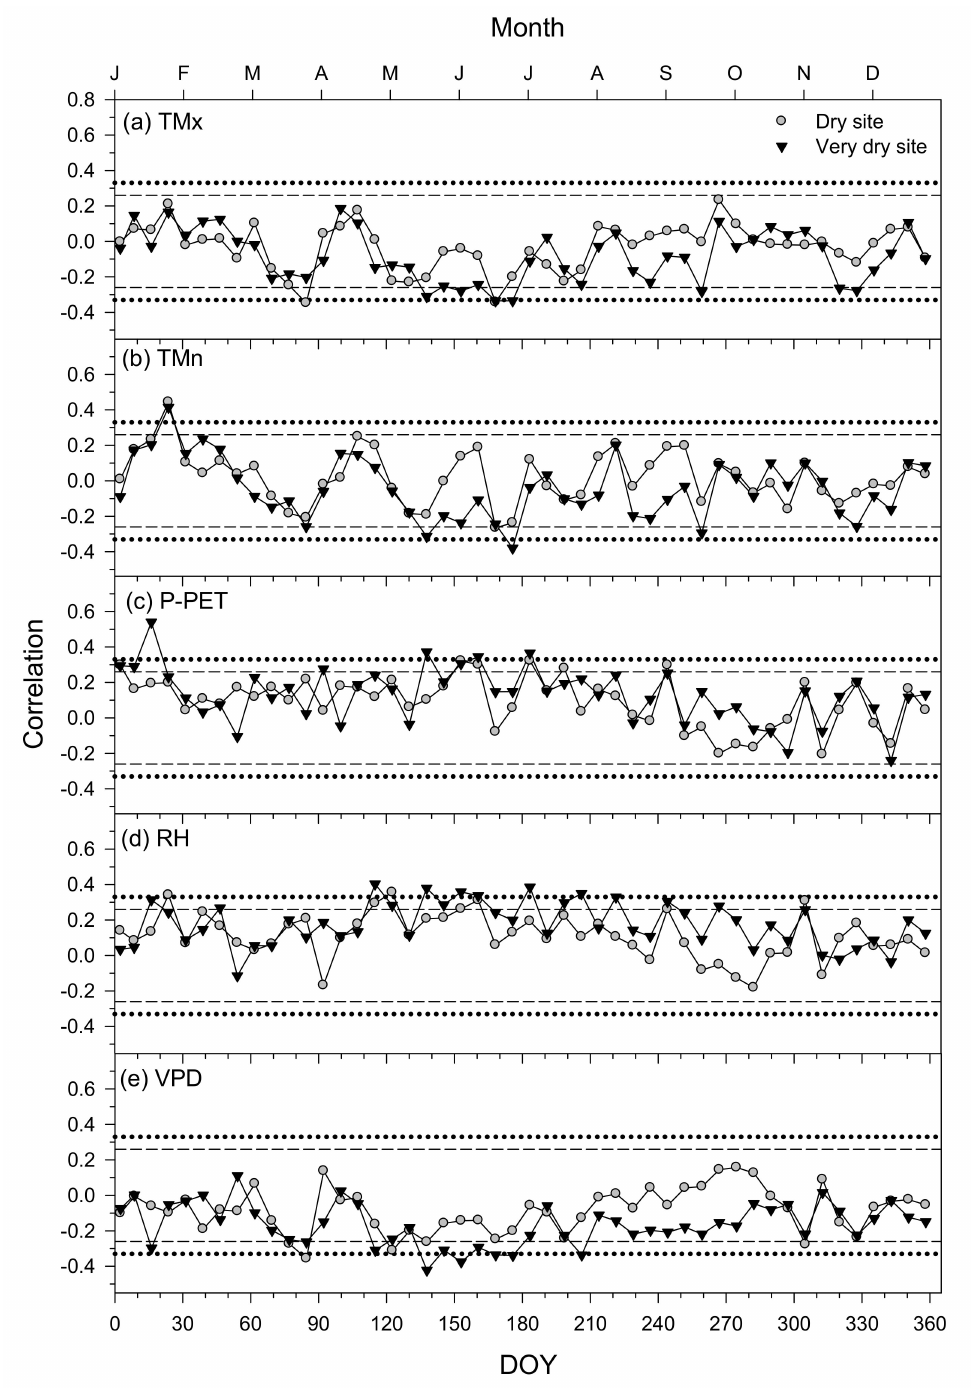
Figure 8. The climate–growth relationships of Pinus halepensis were assessed at a weekly resolution at the dry and very dry sites. The analyzed climate variables were ( a ) TMx, ( b ), TMn, ( c ), P-PET, ( d ) RH, and ( e ) VPD. The horizontal dashed and dotted lines indicate the 0.05 and 0.01 significance levels,